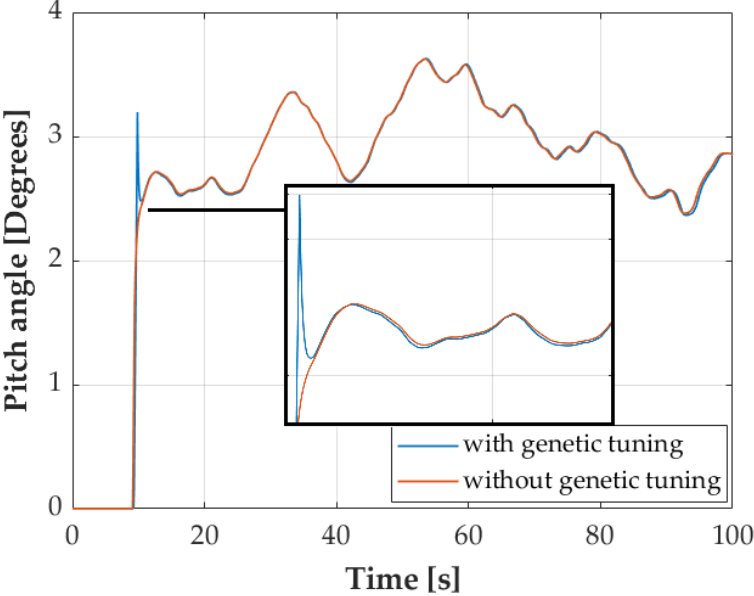
Figure 12. Pitch angle with (blue line) and without (red line) using genetic algorithm.